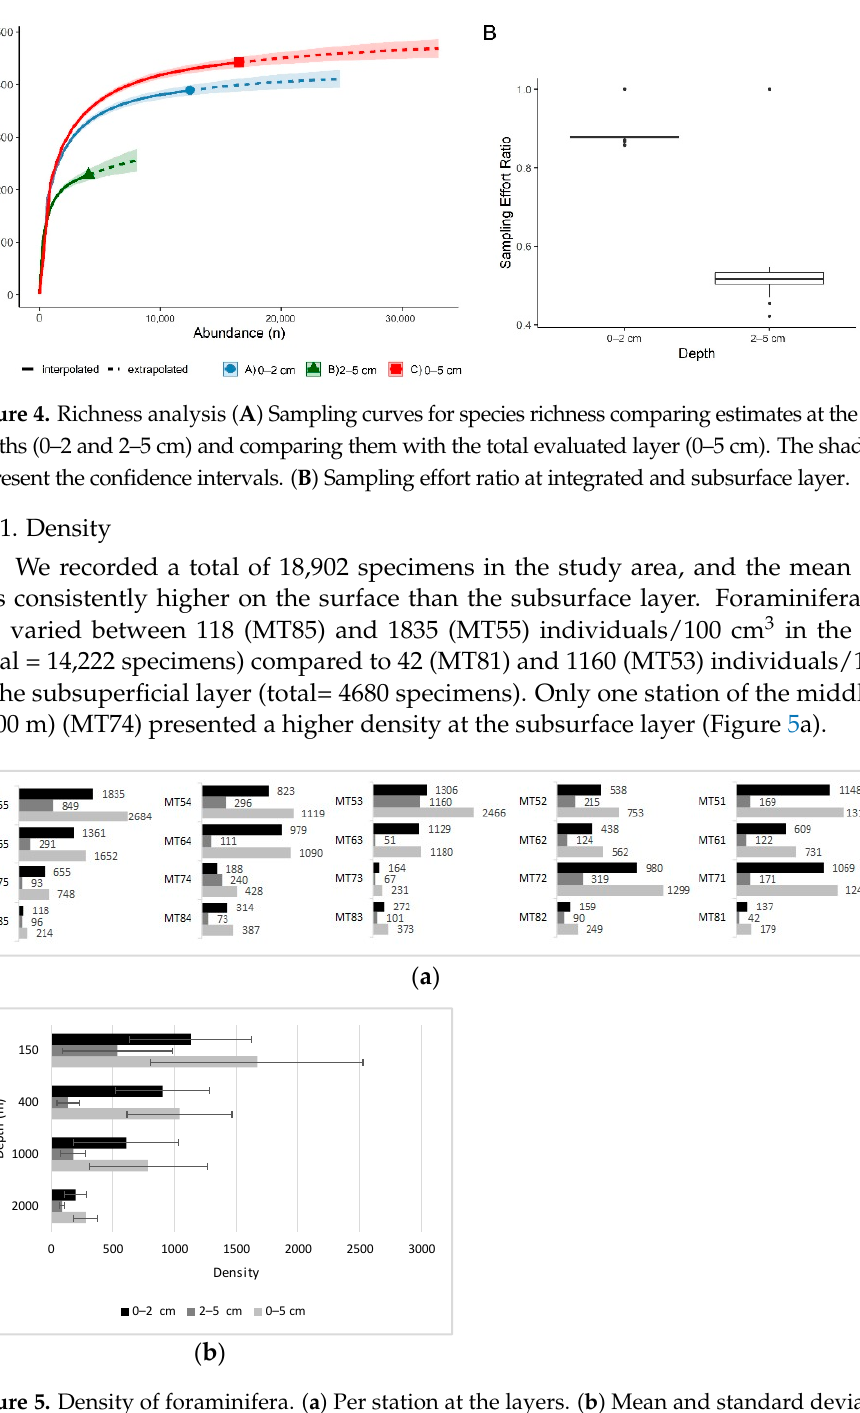
Figure 4. Richness analysis ( A ) Sampling curves for species richness comparing estimates at the different depths (0–2 and 2–5 cm) and comparing them with the total evaluated layer (0–5 cm). The shaded areas represent the confidence intervals. ( B ) Sampling effort ratio at integrated and subsurface layer.